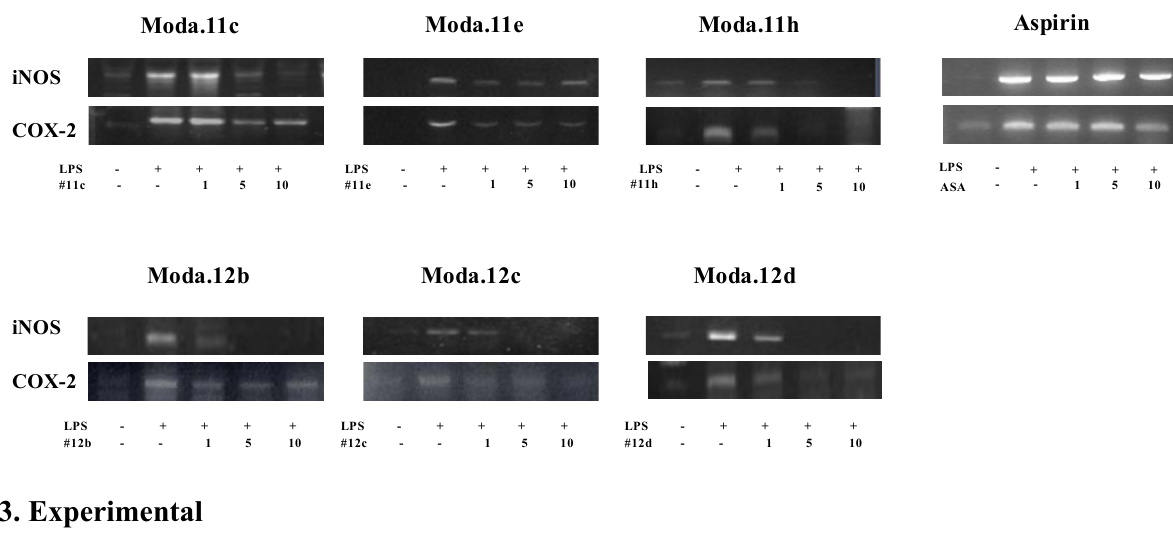
Figure 3. Effects of modafinil derivatives and aspirin (ASA) on inflammation-related enzyme mRNA expression in LPS-treated BV2 cells. Cells were treated by 100ng/ml LPS with or without modafinil derivatives or aspirin (1 µM, 5 µM, and 10 µM) for 24 h. Expression of iNOS and COX-2 was measured by PCR